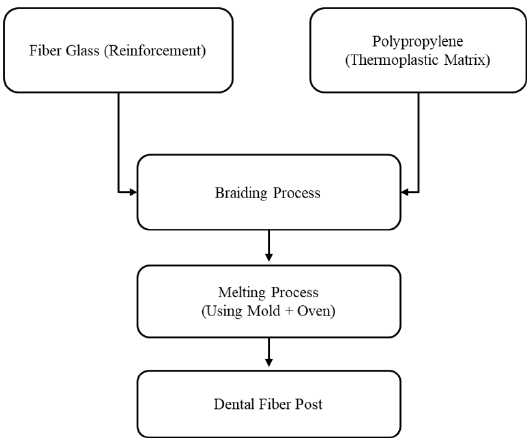
Figure 1. Flowchart for the process used in fabricating the FRP.